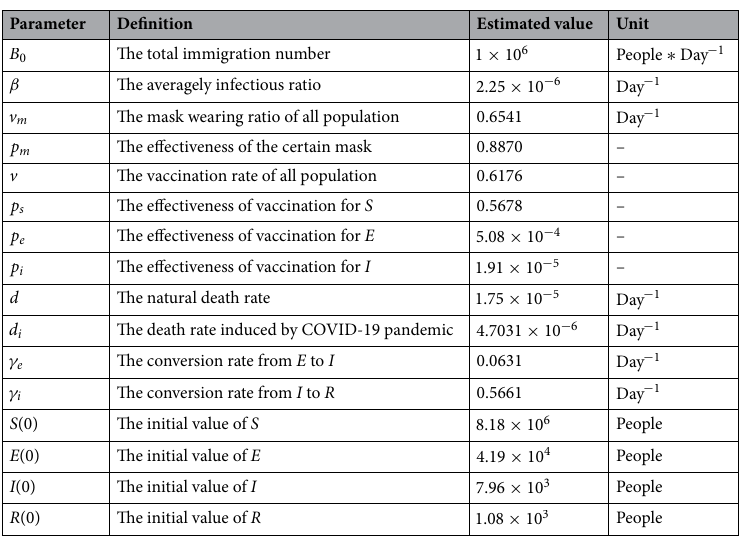
Table 4. The estimated parameter values of model